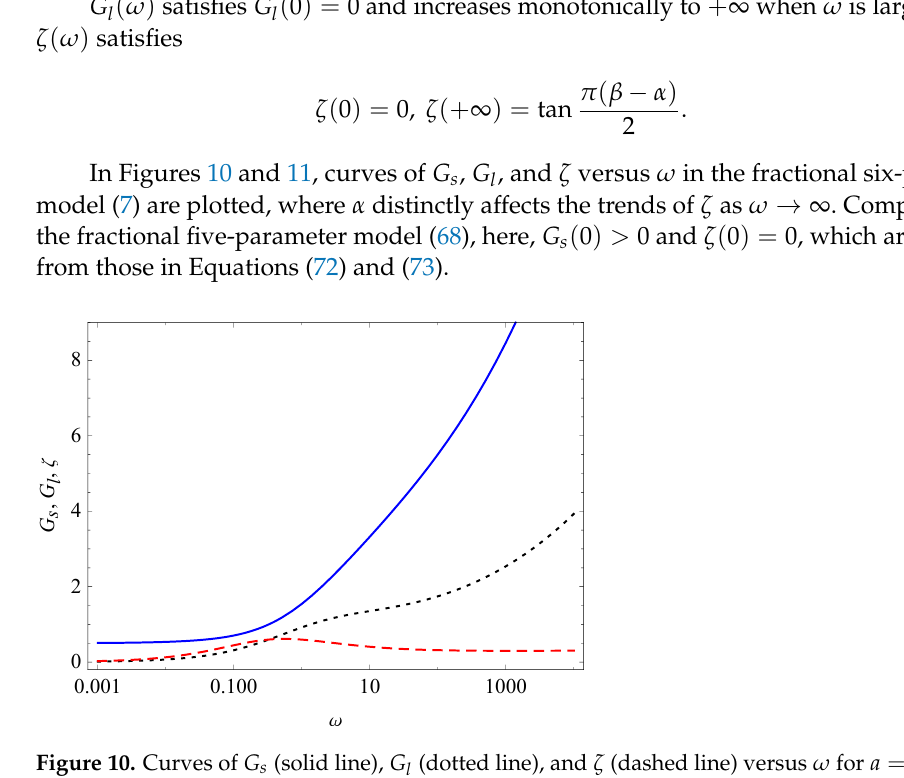
Figure 10. Curves of G s (solid line), G l (dotted line), and ζ (dashed line) versus ω for a = 1, b 0 = 0.5, b 1 = 1, b 2 = 2, α = 0.6, and β = 0.8 in the fractional six-parameter model